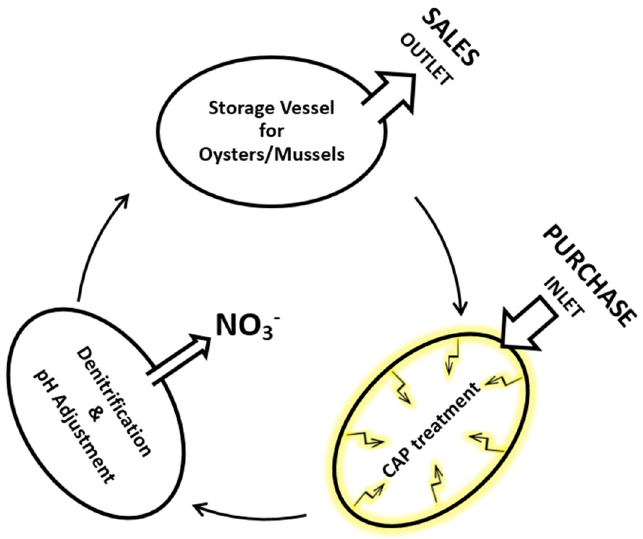
Figure 2. Concept of a circulation system for denitrification and cold atmospheric plasma treatment of stored molluscs (source: authors).